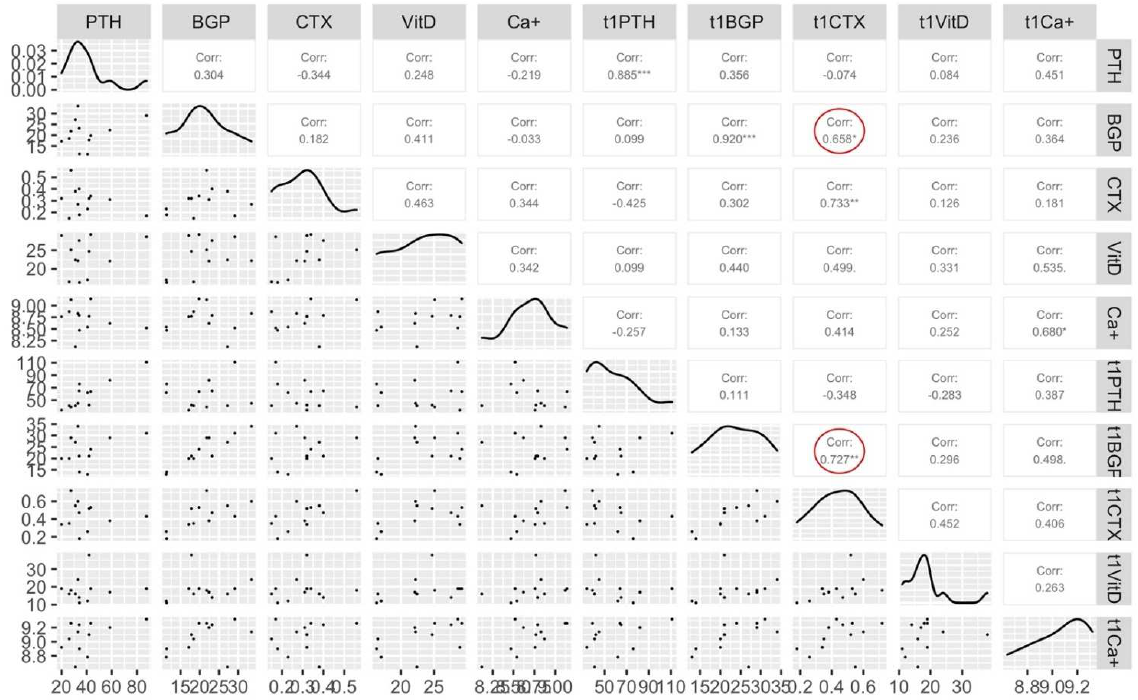
Figure 2. Correlations between all bone markers at baseline (T0) and after 11 weeks of training (T1). “*” = significative difference ( p < 0.05), “**” = significative difference ( p < 0.01) between T0 and T1 for Pearson’s correlation. PTH = parathyroid hormone, BGP = bone-GLA-protein (osteocalcin), CTX = C-terminal telopeptide, VitD = vitamin D, Ca+ = calcium.